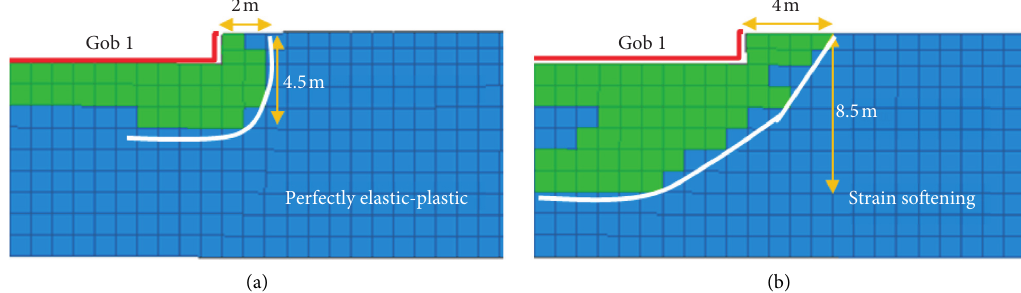
Figure 12: Changes in the plastic zone of the softening 4.1. Stress Monitoring. Five survey lines are arranged in the